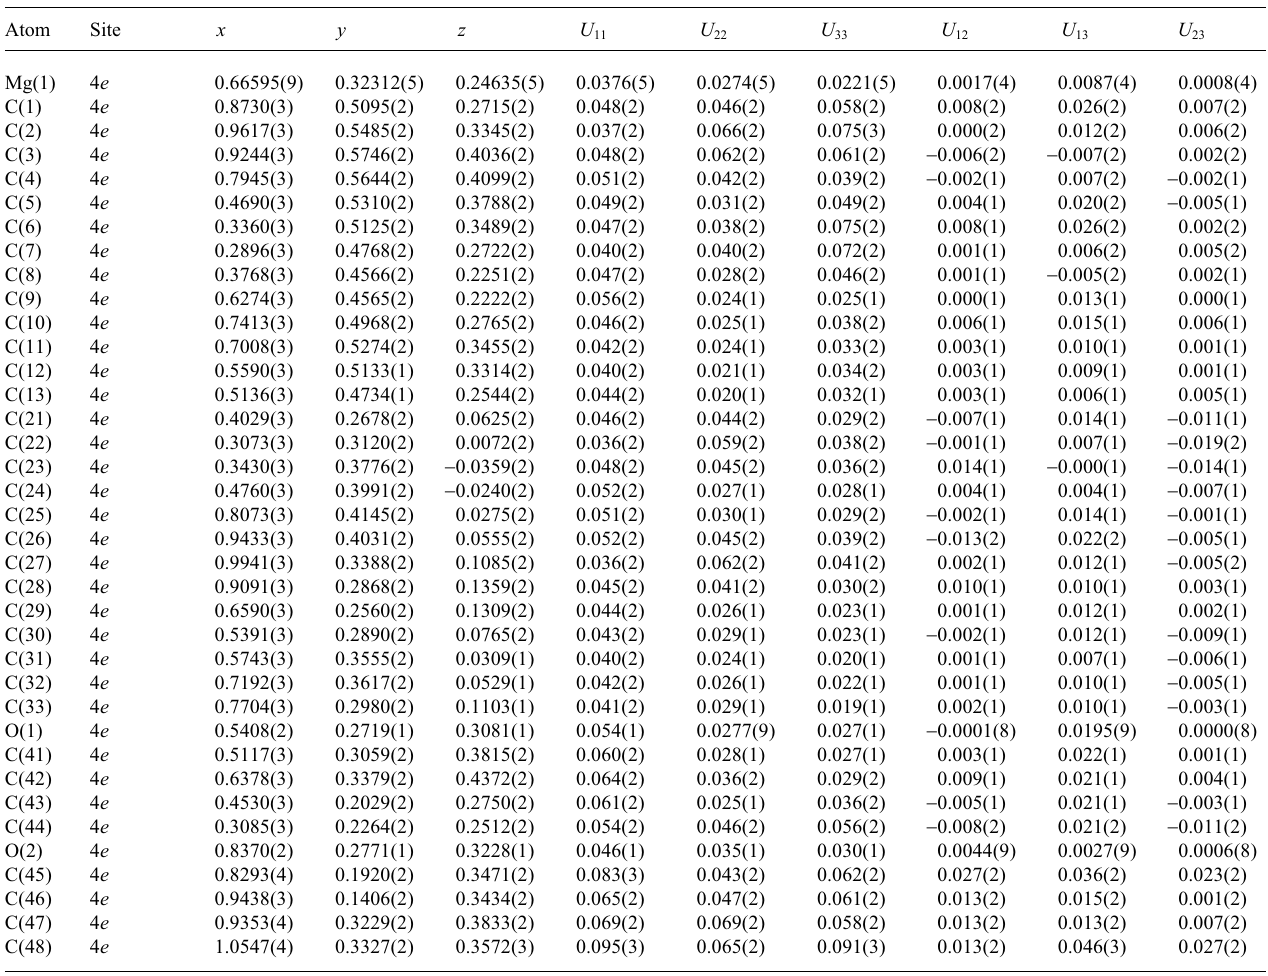
Table 3. Atomic coordinates and displacement parameters (in Å 2 )